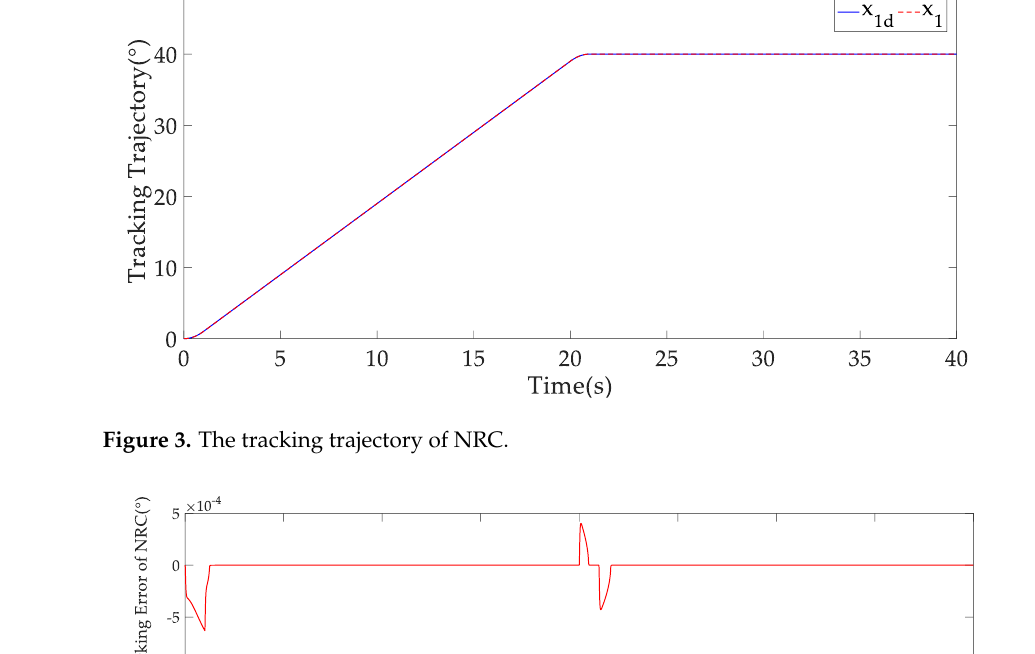
Figure 5. The control input in NRC.